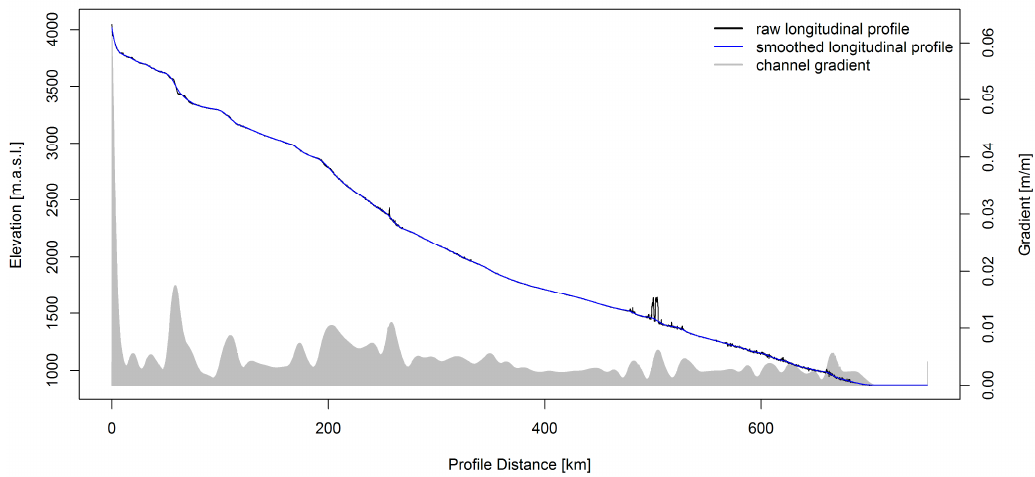
Figure 4. Longitudinal profile of the Naryn River based on the original elevation values (black line) and values smoothed by means of a constrained quantile regression (blue line); additionally, the channel gradient derived from the smoothed elevation values is shown in light grey.